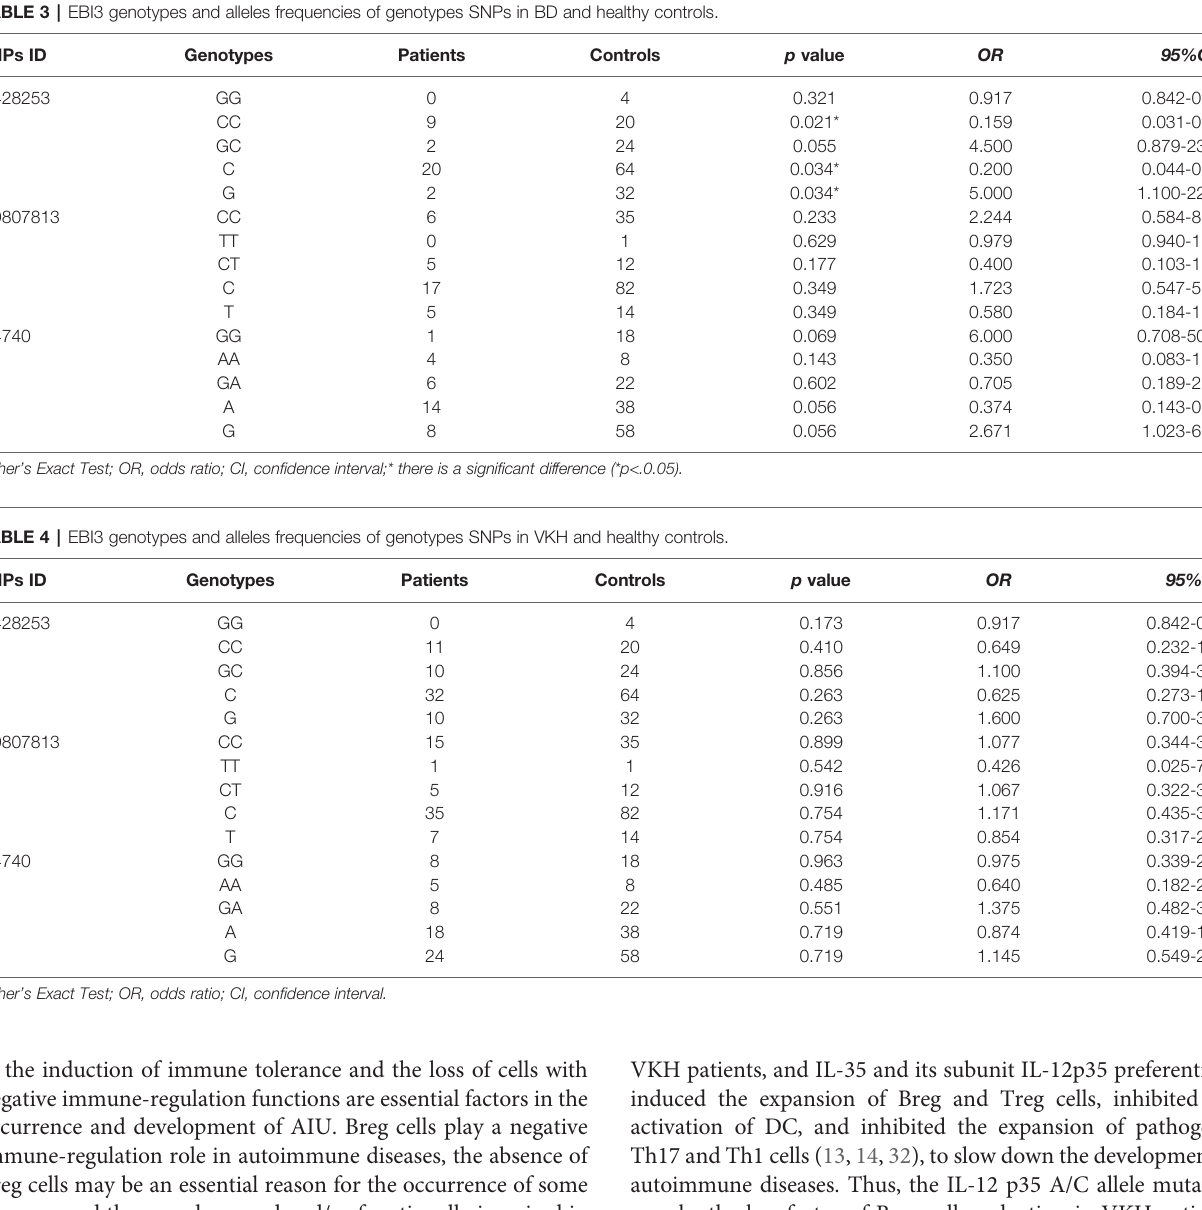
TABLE 3 | EBI3 genotypes and alleles frequencies of genotypes SNPs in BD and healthy controls. SNPs ID